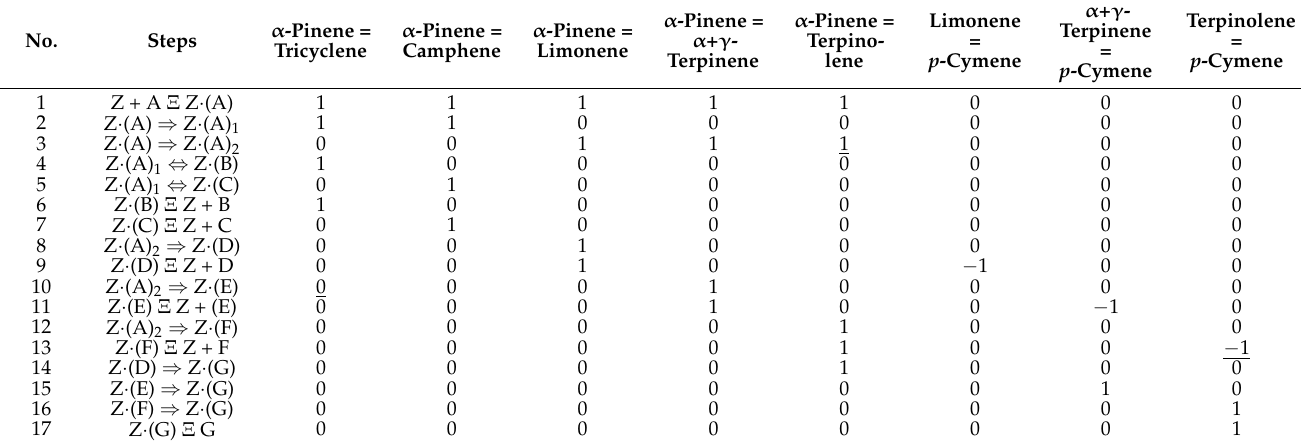
Table 7. Reaction mechanism for α -pinene